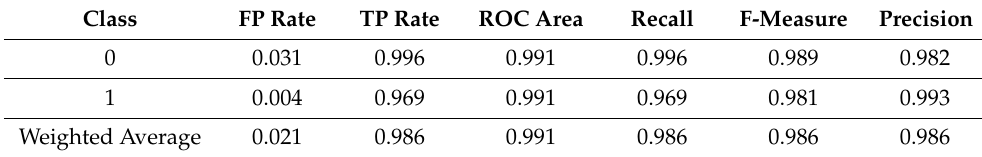
Table 7. Evaluation metrics for J48 DT.